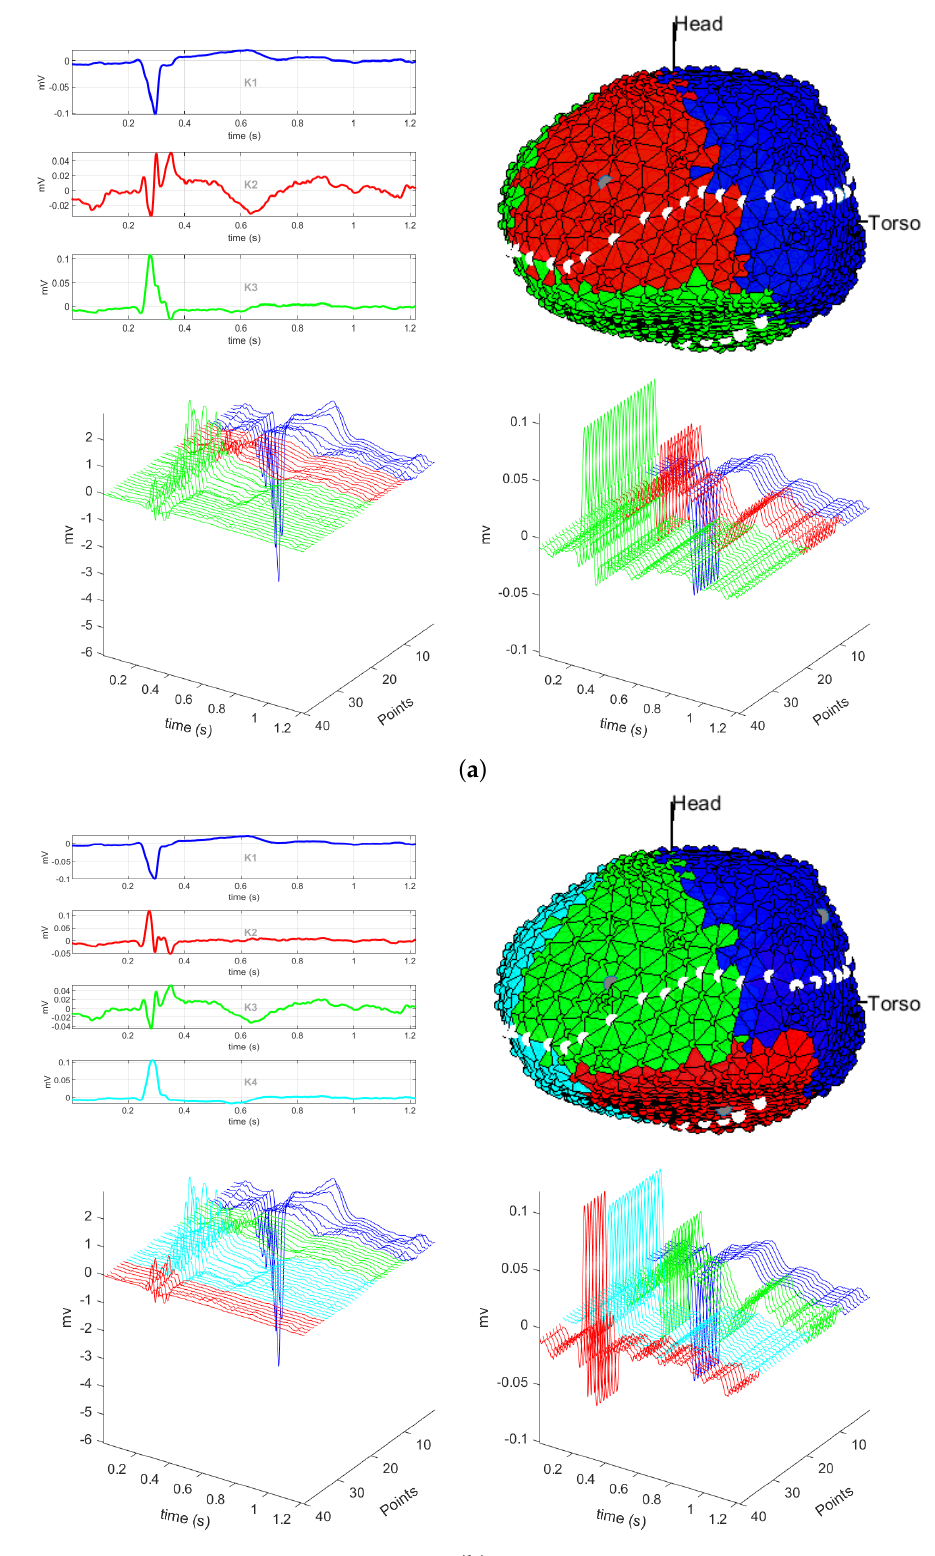
Figure 2. Unipolar EGM in the presence of infarction, using cosine distance with K = 3 ( a ) and with k = 4 ( b ). For each panel: (Up) centroids of each class and clustering map; (Down) M-mode of the unipolar EGM for the dotted line (left), and M-mode of their corresponding centroids